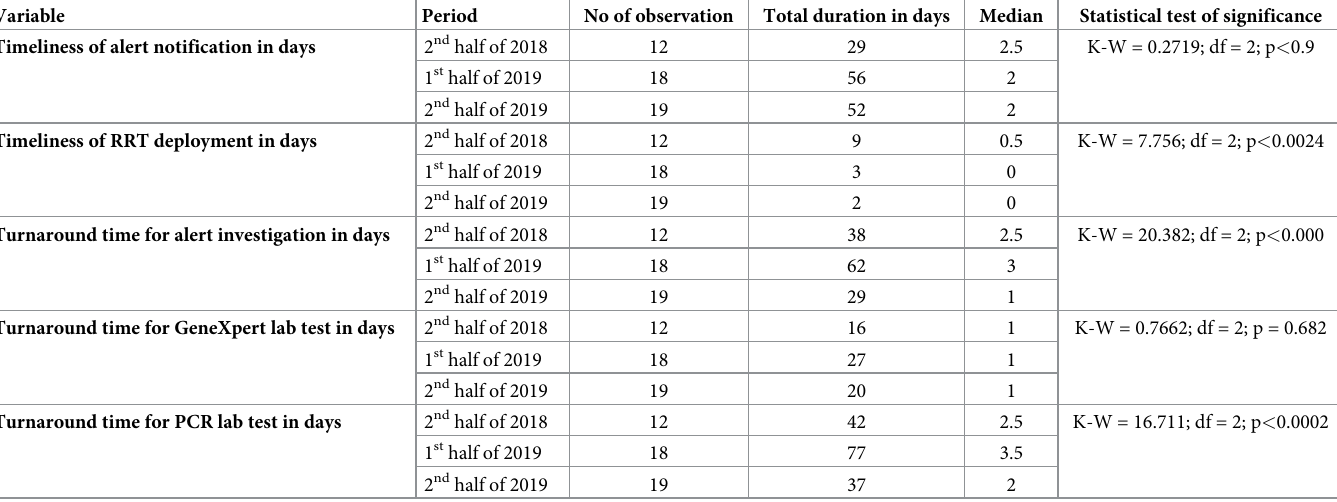
Table 4. Timeliness of investigation of EVD alerts in South Sudan–August 2018 to October 2019.